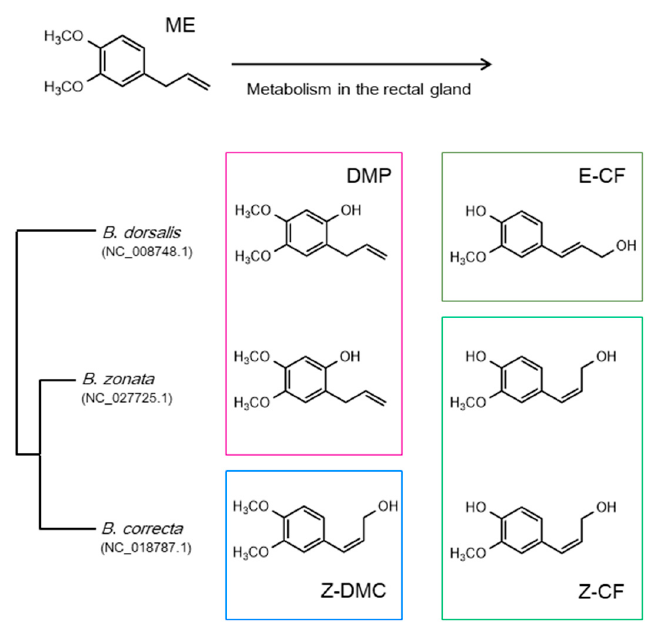
Figure 3. Metabolites of methyl eugenol in three Bactrocera -related species. The phylogenetic tree was constructed from mtDNA sequences by the maximum likelihood method. The accession numbers of the mtDNA sequences are indicated in the parentheses. ME: methyl eugenol; DMP: 2-allyl-4,5- dimethoxyphenol; Z-DMC: ( Z )-3,4-dimethoxycinnamyl alcohol; E-CF: ( E )-coniferyl alcohol; Z-CF: ( Z )-coniferyl alcohol